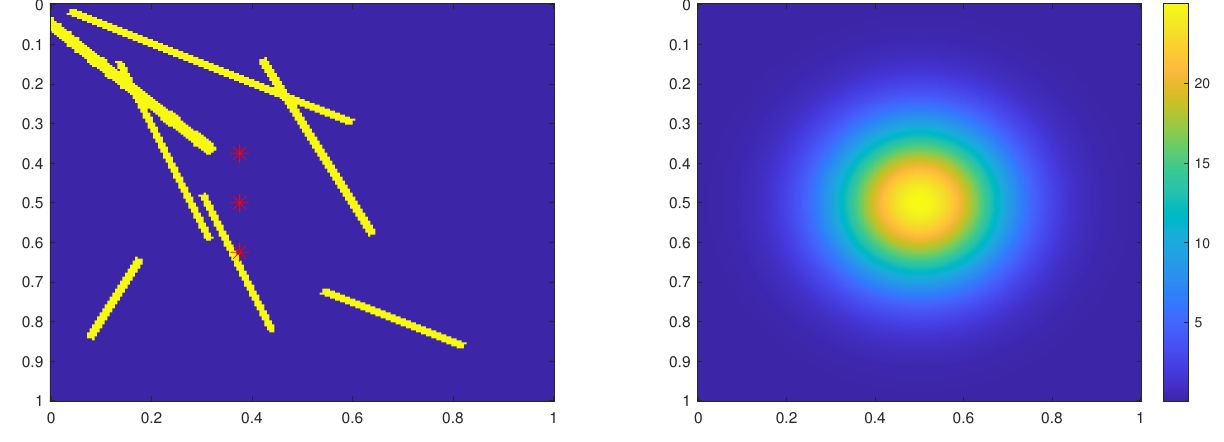
Figure 6. Left : medium κ with marker indicating three locations for comparison, Right : source function f .